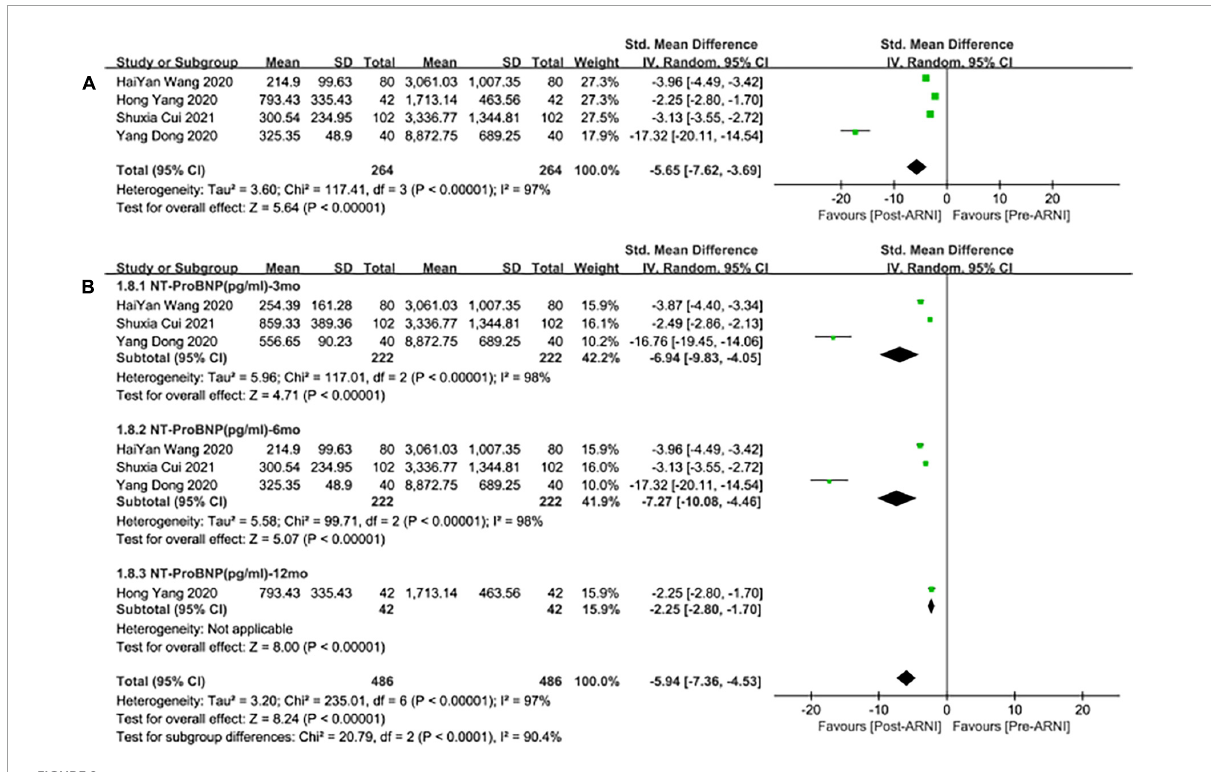
FIGURE9 Forest plots for the effect of ARNI on remodeling biomarkers (A) and subgroup analysis (B) .